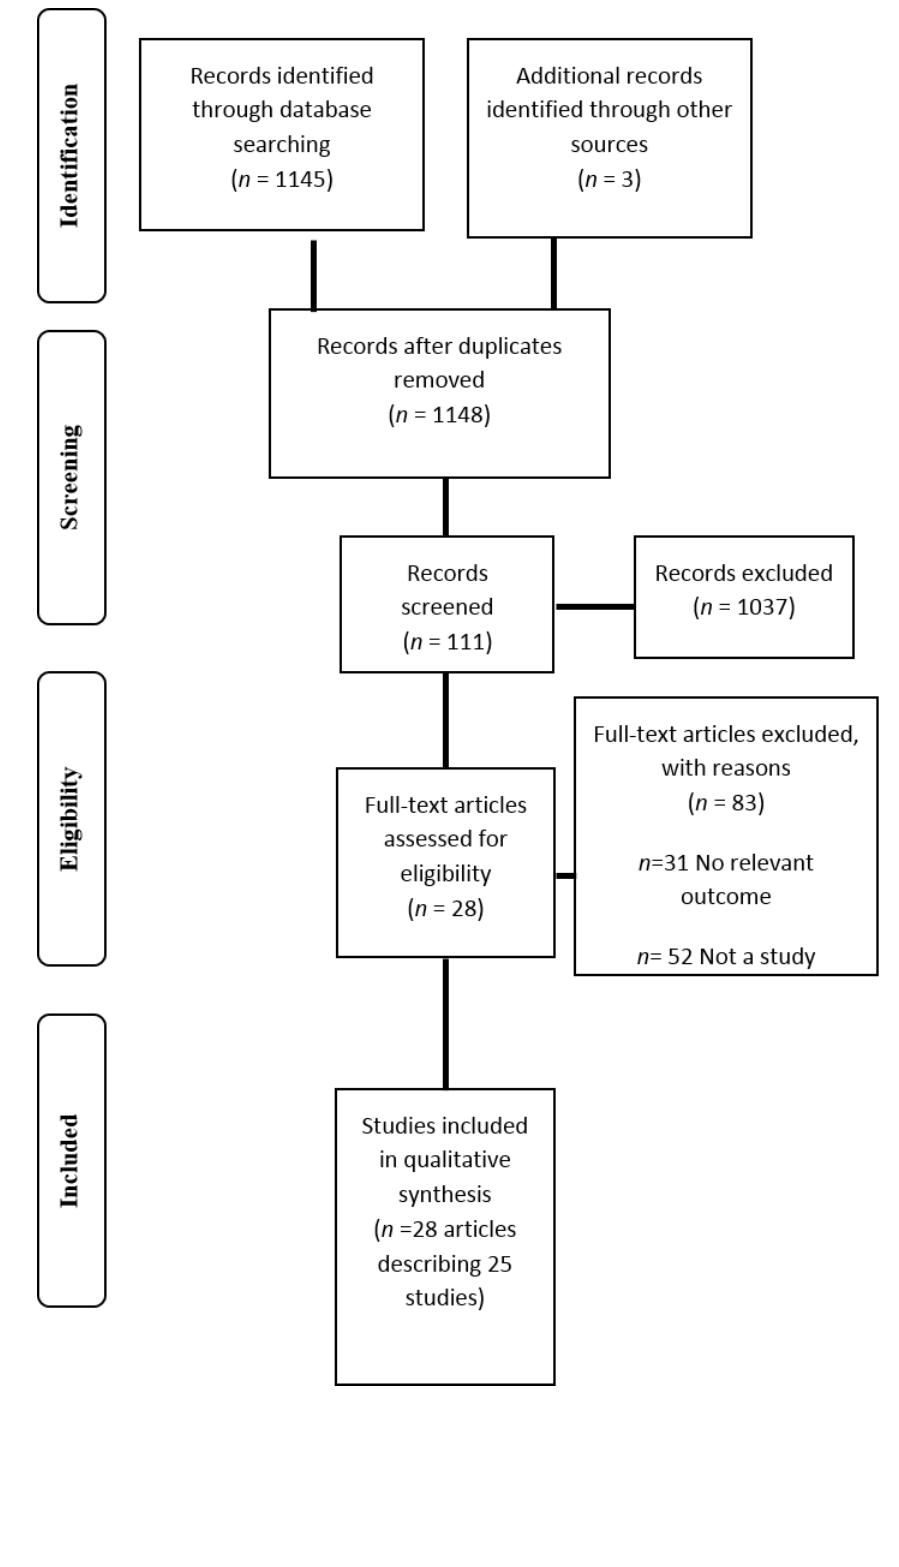
Figure 1. Flow diagram of studies included in the